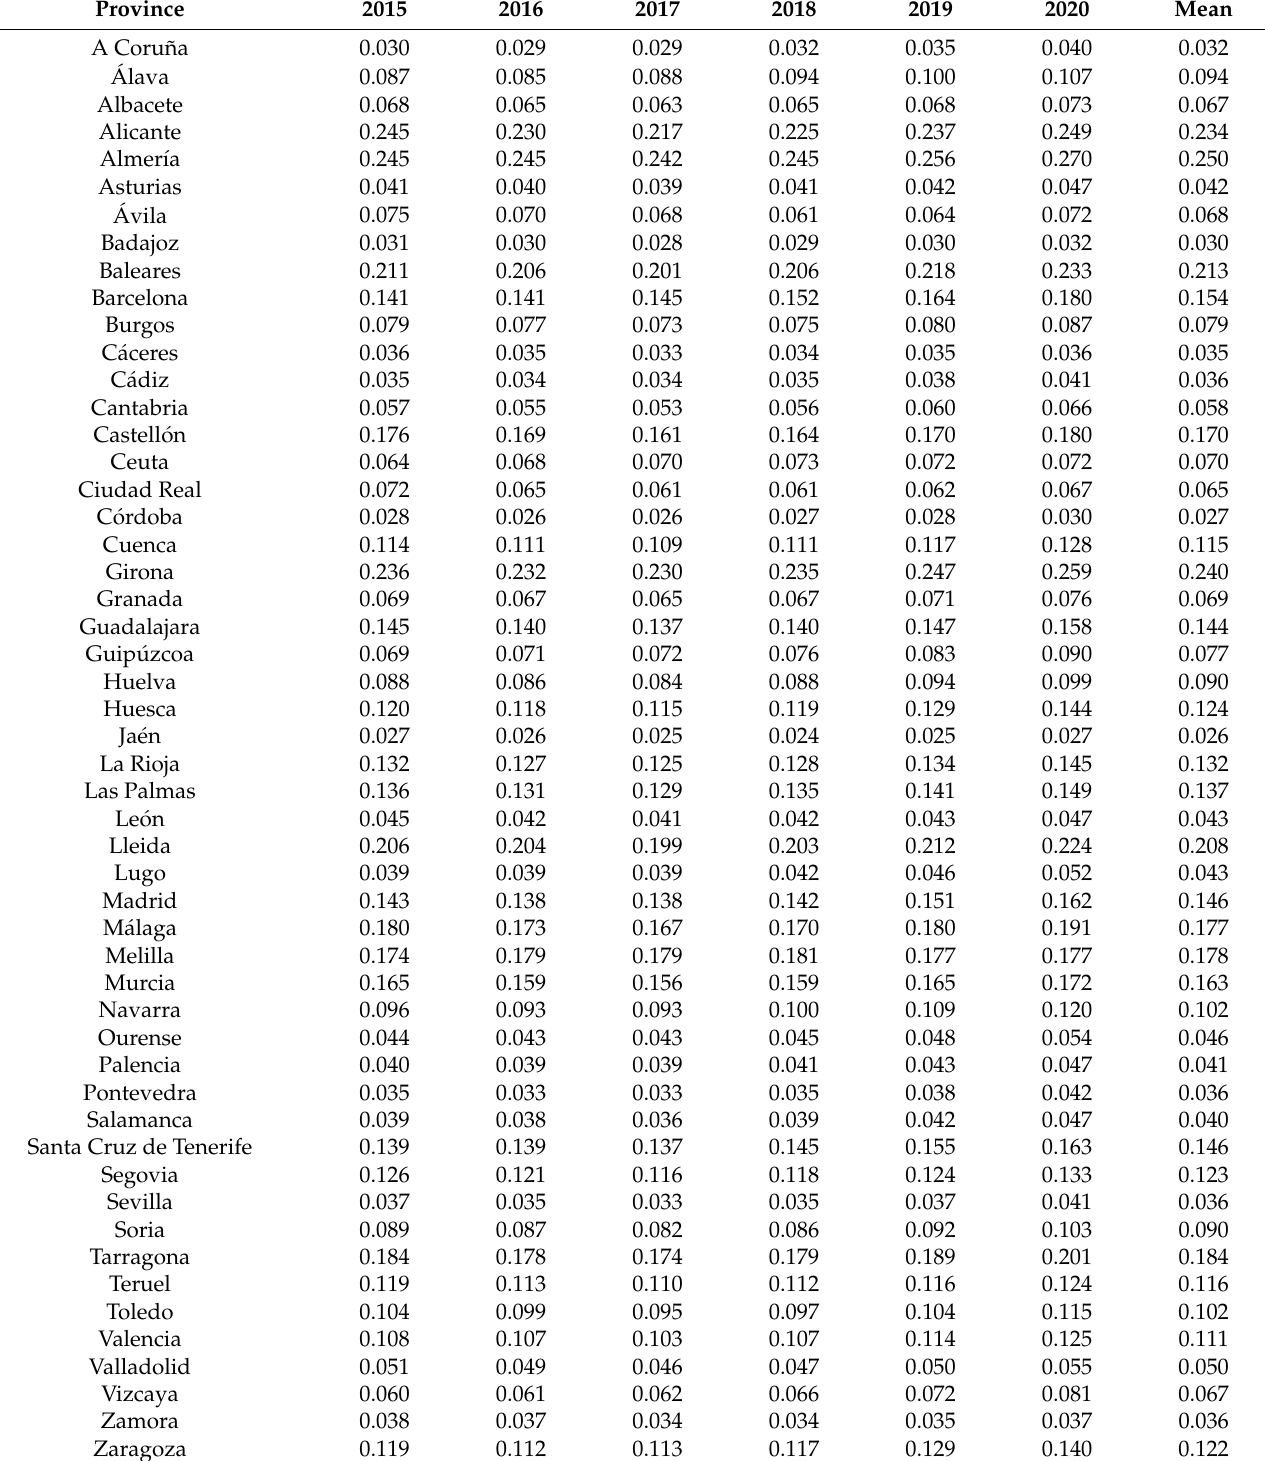
Table A1. Percentage of foreign population in Spain 1 by provinces (NUTS